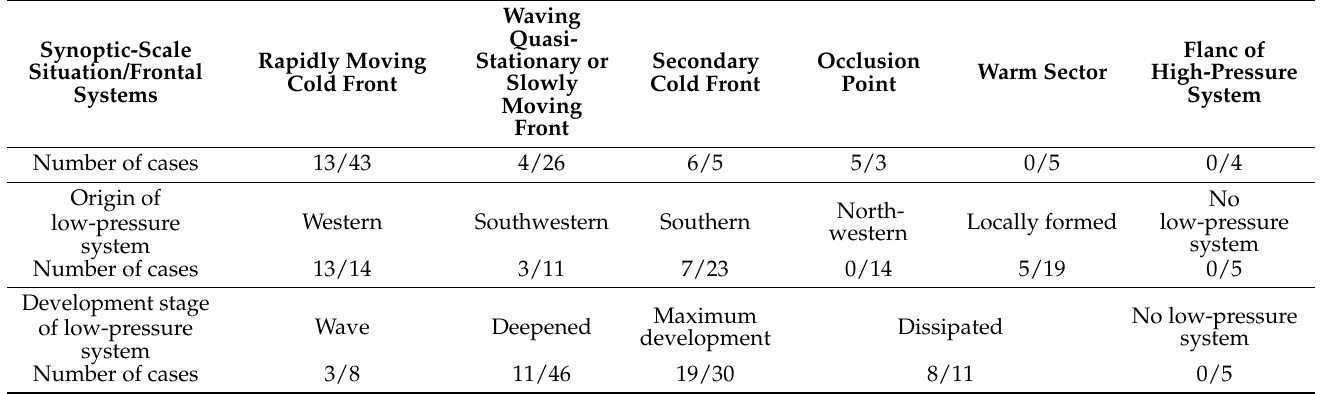
Table 4. Synoptic-scale peculiarities of storm events formation (for SGE WT / SGE NT